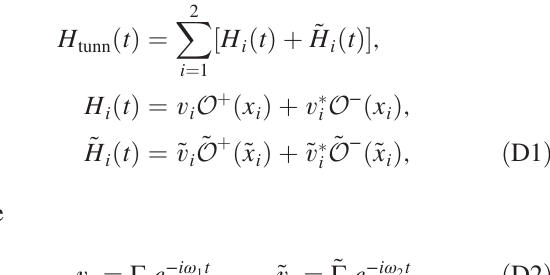
P ~ ϕ cos ð m are I Þ I